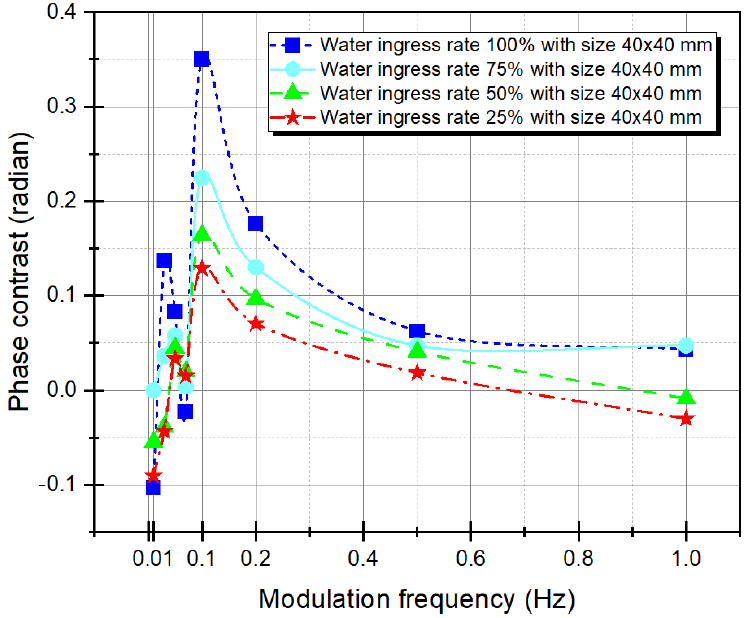
Figure 7. Phase contrast with the four-point method as a function of modulation frequency.